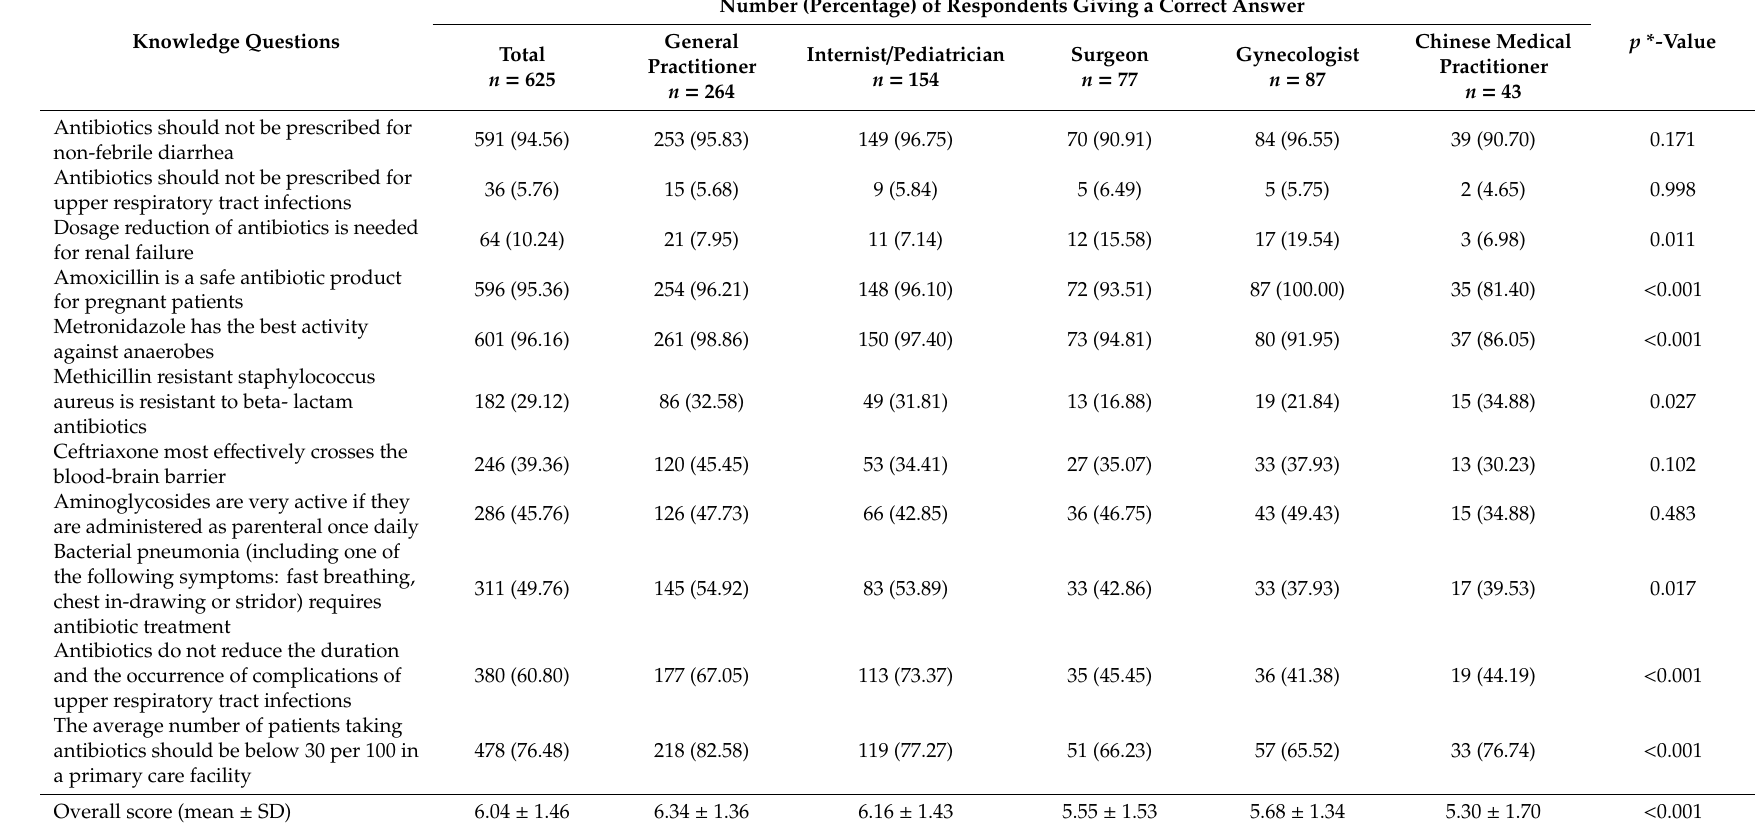
Table 2. Knowledge of respondents about antibiotic